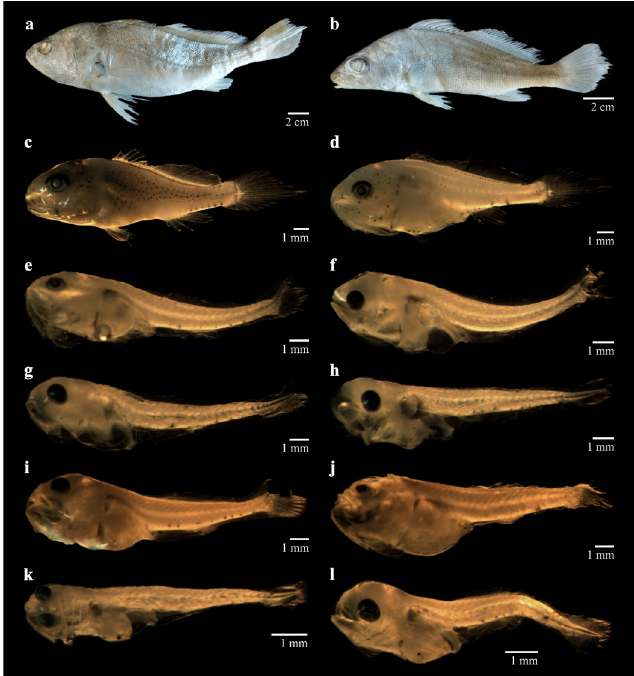
Figure 2. Photographs of adults and larvae of croakers used in this study. ( a ) Adult Plagioscion ternetzi (PGPA-11). ( b ) Adult Pachyurus bonariensis (PGPA-12). ( c ) Larva (PGPA-1). ( d ) Larva (PGPA-2). ( e ) Larva (PGPA-3). ( f ) Larva (PGPA-4). ( g ) Larva (PGPA-5). ( h ) Larva (PGPA-6). ( i ) Larva (PGPA-7). ( j ) Larva (PGPA-8). ( k ) Larva (PGPA-9). ( l ) Larva (PGPA-10). The codes in parentheses indicate collection numbers assigned within the “Proyecto de Biología Pesquera